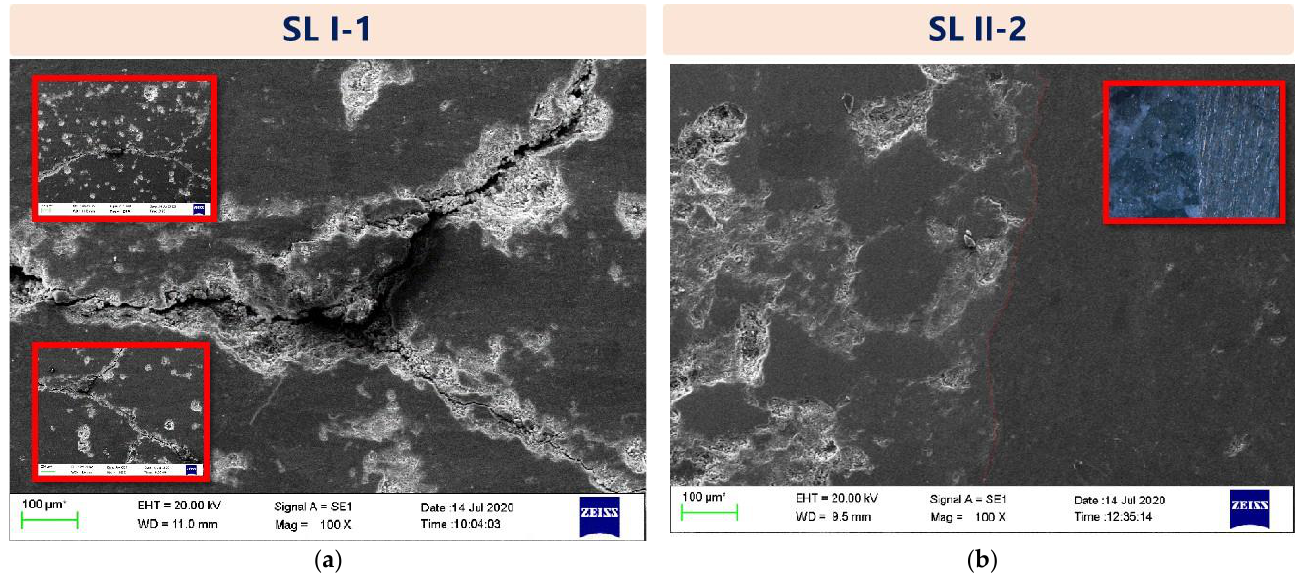
Figure 9. SEM micromorphology analysis of crack distribution characteristics: ( a ) SL I-1; ( b ) SL II-2.